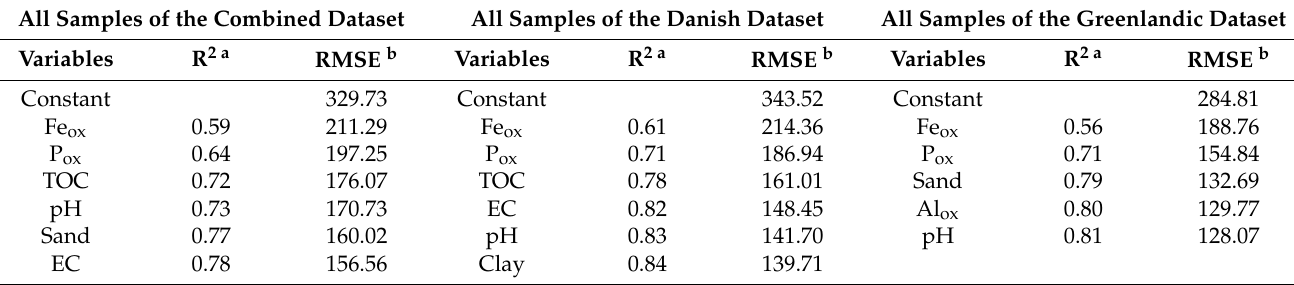
Table A2. Results for the forward stepwise MLR analysis to predict the K d (L kg − 1 ) of glyphosate with all samples for each dataset.